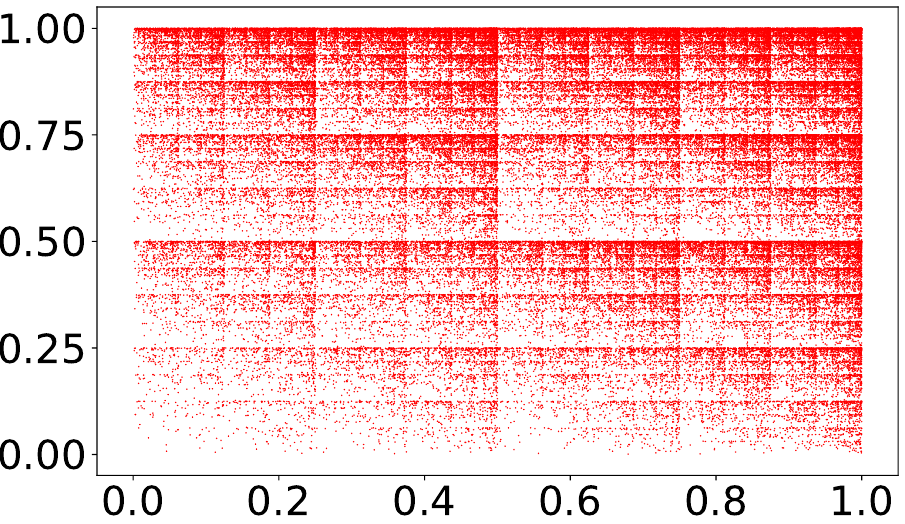
Figure 1. The random multifractal set obtained through a multiplicative process, as described in the text, for the case of N = 10 5 points.